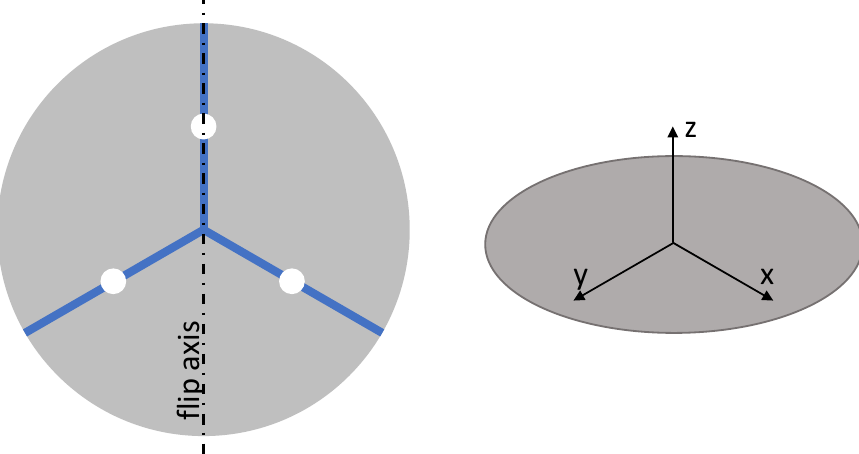
Figure 1. Left: layout of a regular three-point support. Right: system of coordinates. Figure 1. Left : layout of a regular three-point support. Right : system of